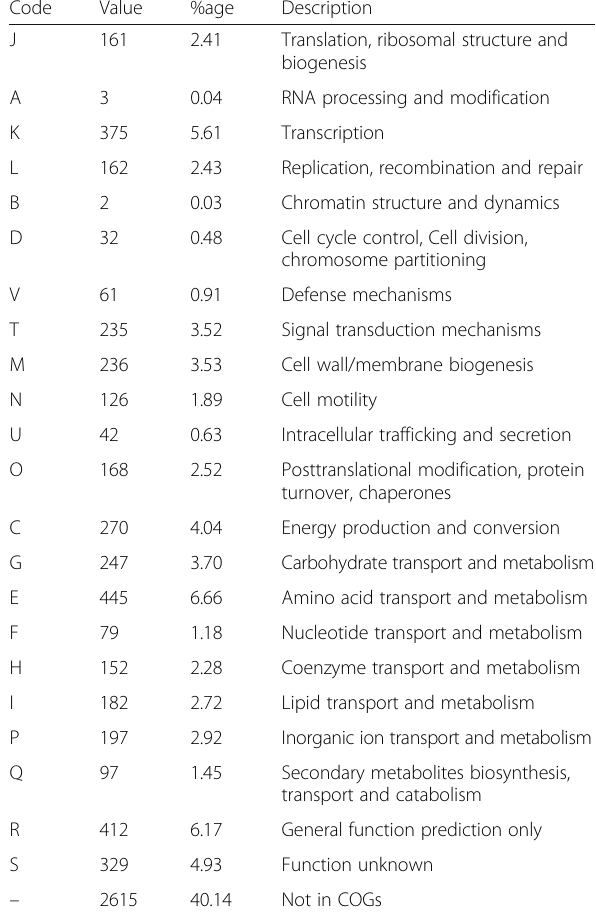
Table 4 Number of genes associated with general COG functional